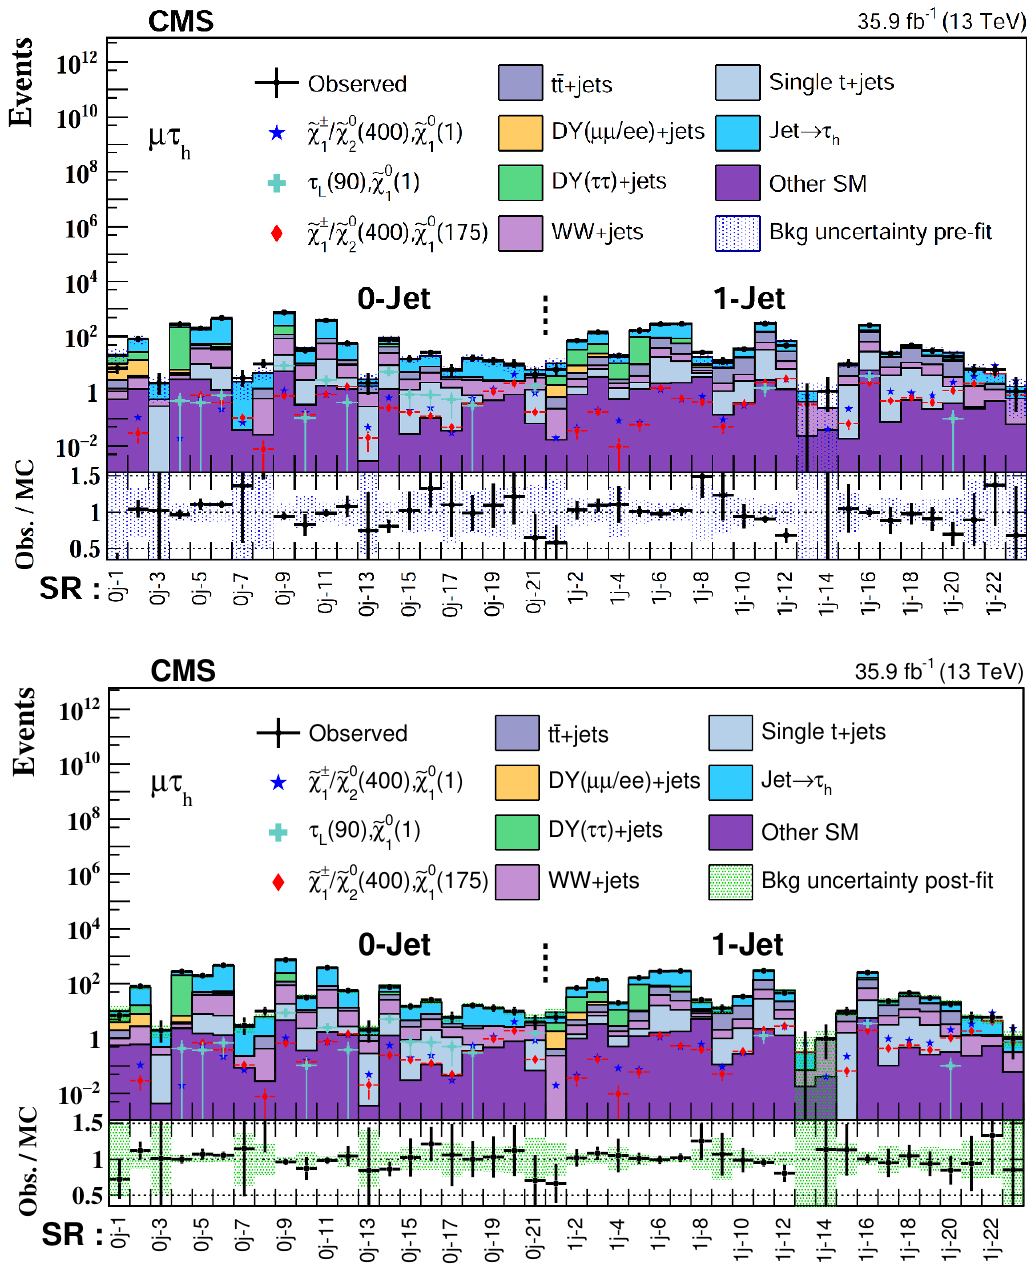
Figure 9. Pre-(cid:12)t (upper) and post-(cid:12)t (lower) results for the SRs used for the (cid:12)nal signal extraction in the (cid:22)(cid:28) h (cid:12)nal state. Distributions for two benchmark models of chargino-neutralino production, and one of direct left-handed (cid:28) pair production, are overlaid. The numbers within parentheses in the legend correspond to the masses of the parent SUSY particle and the (cid:31) 0 in GeV for these 1 benchmark models. In the ratio panels, the black markers indicate the ratio of the observed data e in each SR to the corresponding pre-(cid:12)t or post-(cid:12)t SM background prediction. e